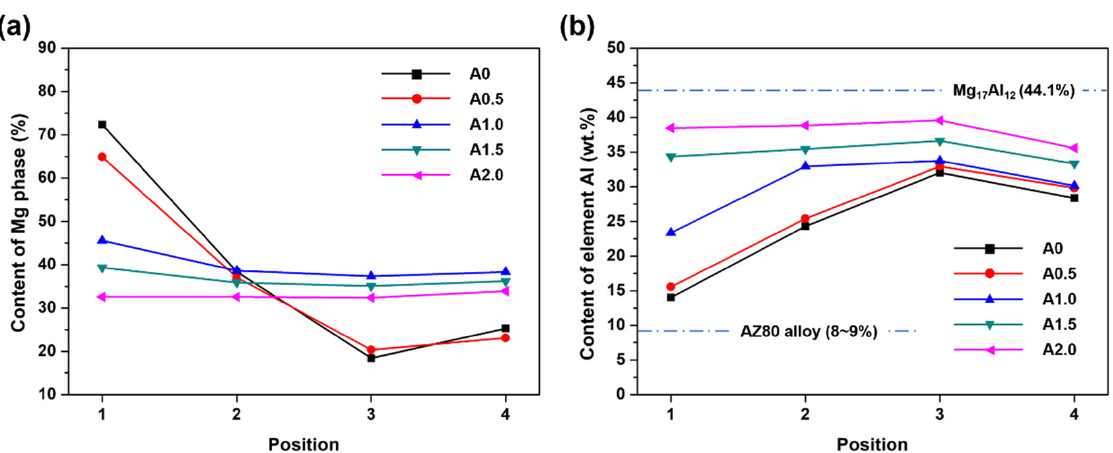
Figure 8. α -Mg phase content ( a ) and Al element content ( b ) in different positions of the weld seam cladded with different oscillating amplitudes.